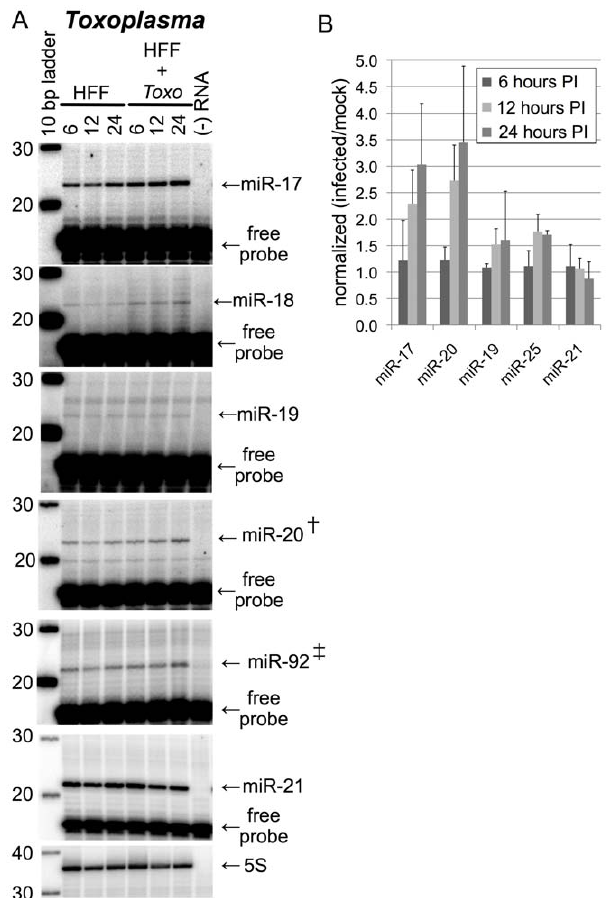
Figure 2. Primer-extension analysis shows that Toxoplasma infection specifically increases levels of host miR-17, miR-18, miR-19 and miR-25 family members. (A) Total RNA samples were extracted from HFFs during a 24-hour timecourse of Toxoplasma- infection, and subject to primer extension analysis. From left to right, template RNAs were derived from uninfected HFFs at 6, 12 or 24 hours, or from infected HFFs at the same time points. Shown are representative autoradiographs for each primer-extension probe; all reactions were performed on biological triplicates. All probes were also extended in the absence of template RNA (‘- RNA’ lanes) to identify any primer-extension artifacts associated with each probe. Primer-extension products are shown with arrows and labeled. ( { ) miR-20 is a member of the miR-17 family; ( { ) miR-92 is a member of the miR-25 family. Excess free probe is indicated. The size marker is a 10bp ladder. (B) A graphical summary of the primer-extension data in (A). Each RNA sample was subject to primer-extension with the indicated miR-specific probe and band-intensities were quantified by phosphorimager analysis. These values were normalized to values obtained from an independent primer-extension of each RNA sample with a 5S rRNA probe. The 5S rRNA-normalized infected/uninfected ratios for each timepoint are plotted and error bars are the standard deviation between three biological replicates that were performed for each